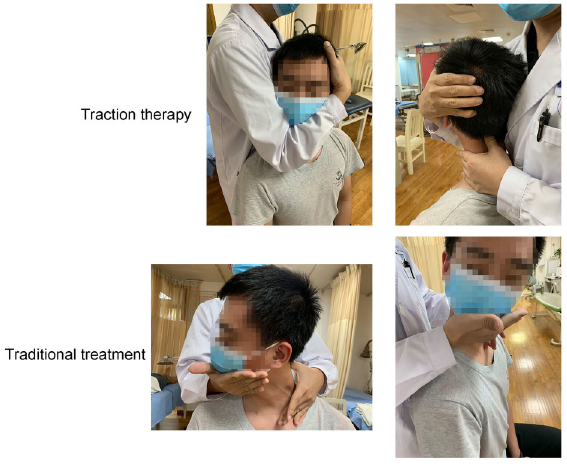
Figure 1. Procedures of traction therapy and traditional